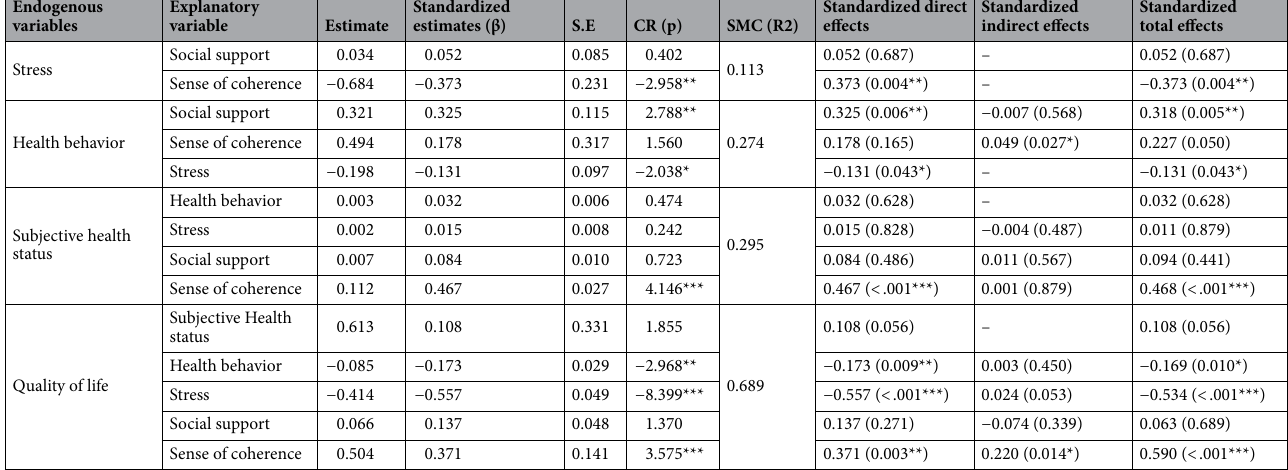
Table 4. Standardized estimates, standardized direct, indirect and total effects of the modified mode (n = 239). CR critical ratio, SMC squared multiple correlations. *p < 0.05, **p < 0.01, ***p < 0.001.